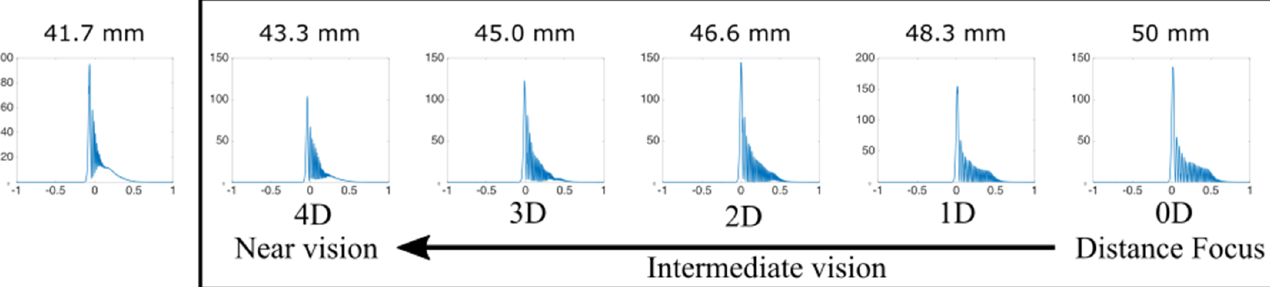
Figure 10. Optimization in the exemplary case of an EDOF IOL consisting of a combination APM + FL. The value that minimizes the residual (Equation (12)) is for α = 80 ≈ 251/ π .